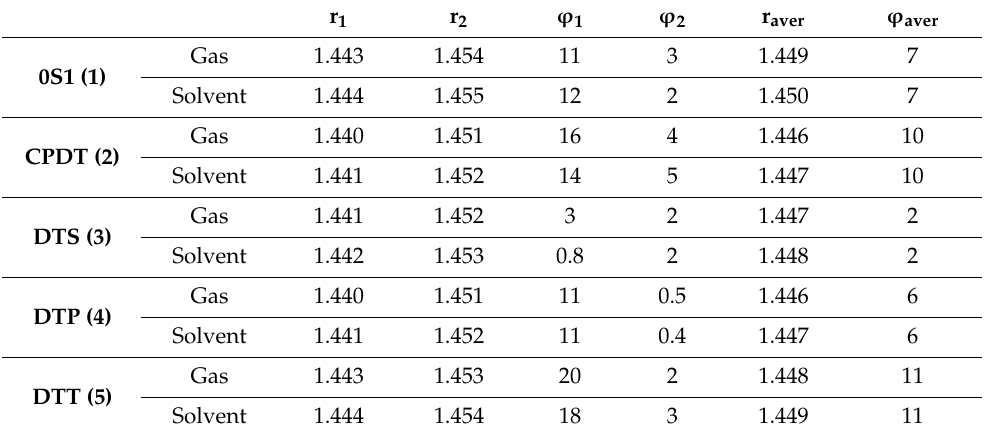
Table 1. Selected bond lengths (in Å) and dihedral angles (in degrees) of the optimized structures